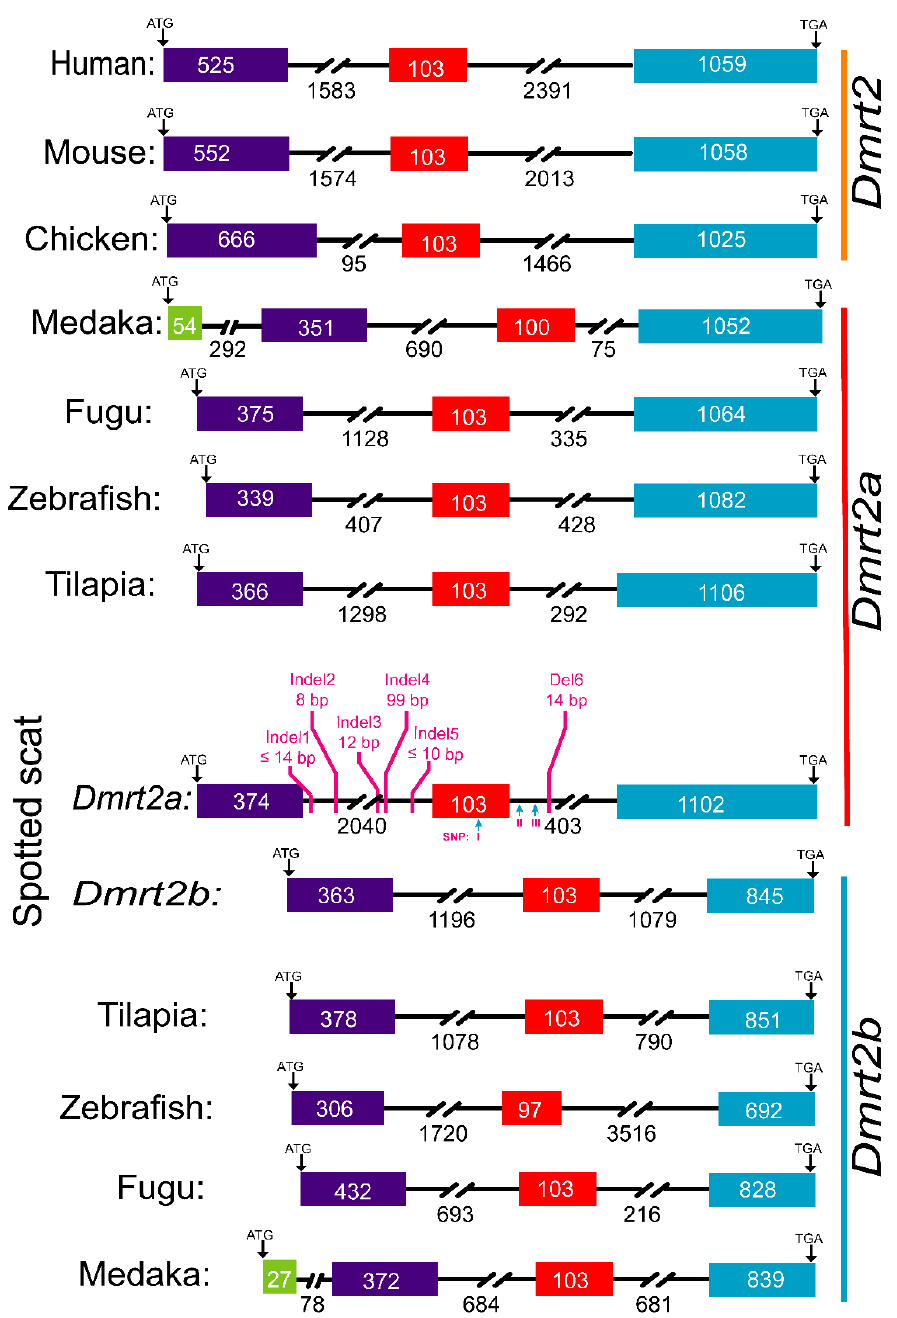
Figure 3. Schematic representation of Dmrt2a and Dmrt2b genes from different species. Boxes and lines indicate exons and introns, respectively. The same colors indicate the same exons. The lengths in bp (base pair) of exons are shown in the boxes, while introns are shown below. Downward arrows indicate start (ATG) and stop (TGA/TAA) codons. Red vertically inclined lines indicate insertions and deletions (indels) on spotted scat Dmrt2a. The polymorphisms in Dmrt2a were obtained from the differences in male and female sequences.